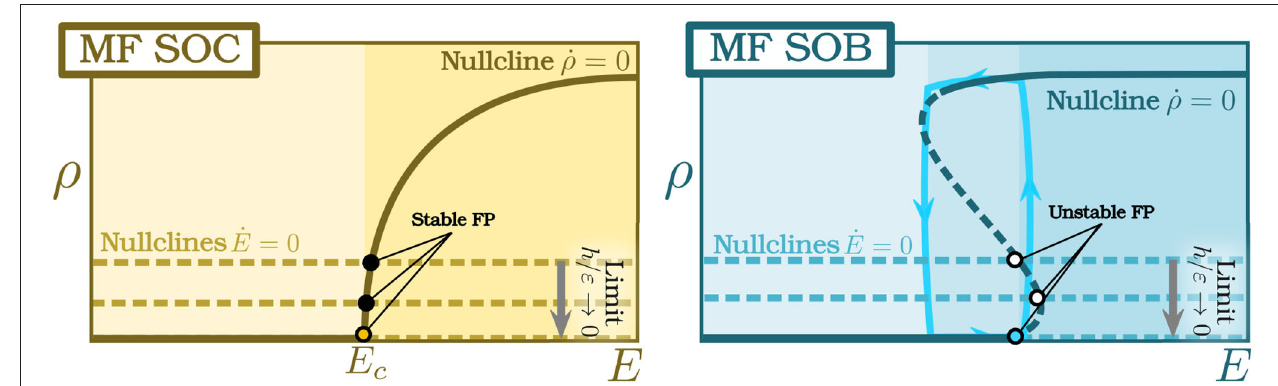
FIGURE 1 | Mean-field (MF) pictures of SOC and SOB. Sketch of the nullclines associated with the two dynamical mean-field equations defining self-organized criticality [SOC, (Left) ] and self-organized bistability [SOB, (Right) ]. In both cases, the nullcline for the second (feedback) equation is plotted for three different values of the ratio h /ǫ . (Left) In the case of SOC, nullclines intersect at a stable fixed point, which becomes closer and closer to the critical point as the limit of infinite separation of timescales h /ǫ 0 is approached (see gray arrow). (Right) In the case of SOB, for sufficiently low values of h /ǫ the intersection between nullclines → occurs on the so-called spinodal line (dashed dark line). Points located in the spinodal line are unstable, and the system presents a stable, fixed-amplitude limit cycle sketched by the cyan trajectory.